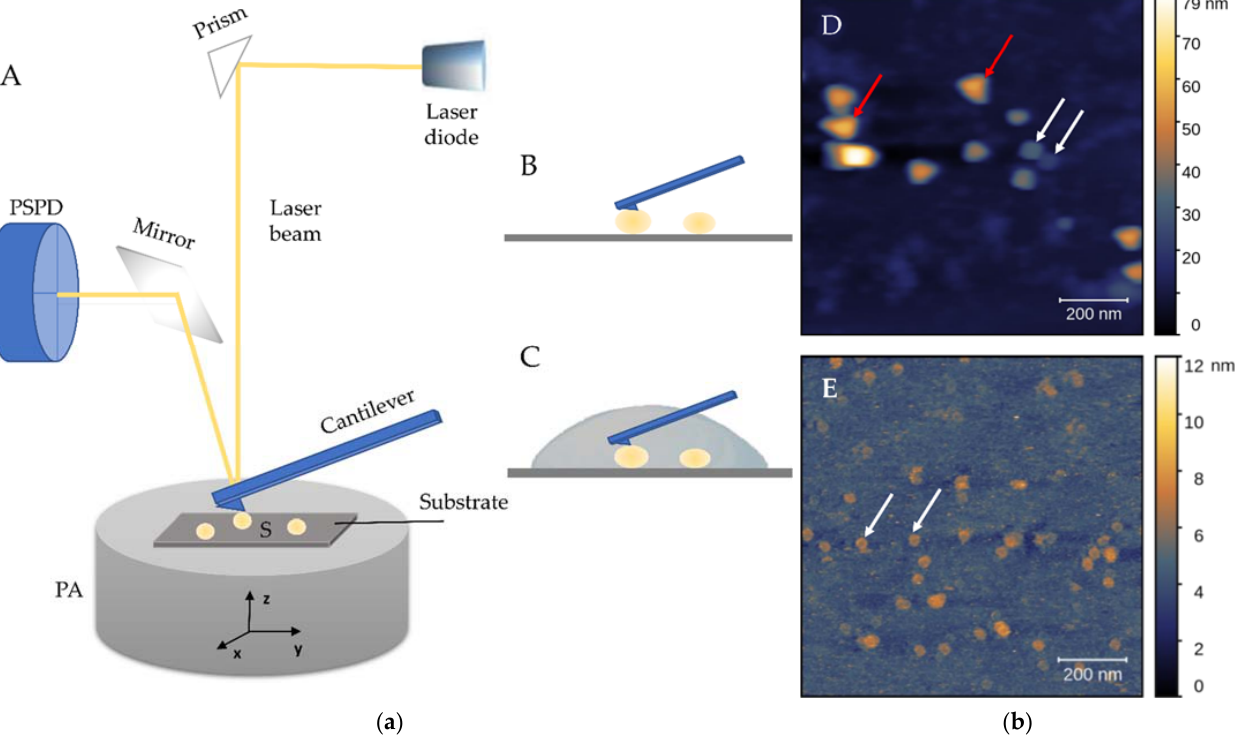
Figure 4. Schematic representations of atomic force microscopy (AFM, ( a ) and images of EVs isolated by the SEC ( b ). ( A ): AFM setup and detail of the tip–sample interaction in air ( B ) or liquid ( C ) environments. PSPD: position-sensitive photodiode, PA: piezoelectric actuator, S: sample. Representative images of EVs in air ( D ) and liquid ( E ). ( D) : sample fixed with PFA, on mica, analysed using MFP-3D (Asylum Research) with OMCL/TR400PSA-HW (Olympus) probes in tapping mode, EV-like structures are pointed with white arrows and possible convolution artefacts or phosphate buffer crystals with red arrows; ( E ): sample on a glass coverslip, RCA cleaned and activated with oxygen plasma, analysed using Nanowizard II (JPK Instruments) with MLCT (Bruker) probes in tapping mode, with photothermal excitation, EV-like structures are pointed with white arrows.